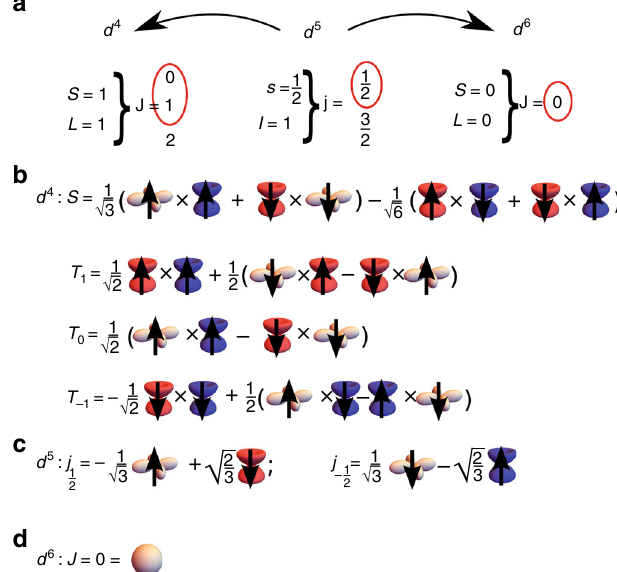
Fig. 1 Low-energy eigenstates of iridium ions. a Quantum numbers characterising certain electronic con fi guration, where j , l , and s ( J , L , and S ) stands for single-particle (multi-particle) total, orbital, and spin angular momentum. The red circles indicate the states that are explicitly taken into account in our effective low-energy theory. b Eigenstates for the 5 d 4 con fi guration (relevant for the 5 d 4 hole case) of the appropriate ionic Hamiltonian of iridium ion. c Same as b but for the 5 d 5 con fi guration (as relevant for the quasi-two-dimensional iridate ground state). d Same as b but for the 5 d 6 con fi guration (relevant for 5 d 6 doublon case). Blue, red and beige cartoon orbitals indicate the one-particle states with the effective angular momentum l = 1 and l z = 1, l z = − 1 and l z = 0 respectively. Round beige cartoon orbital indicates full shell with L = 0. Up (down) black arrows indicate s z = 1/2 ( s z = 1/2) of spin s = 1/2 states. No arrow on an orbital indicates S = 0